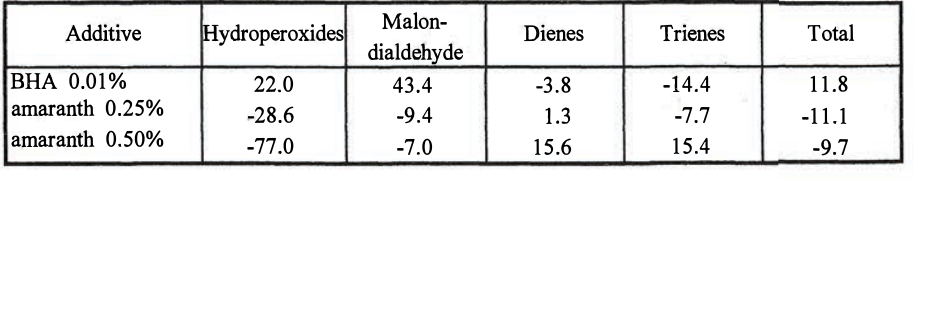
Fatty acid composition of amaranth seed lipids